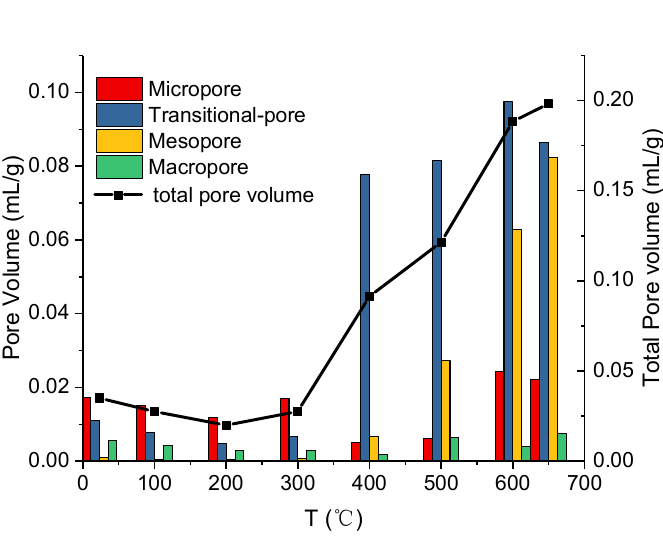
Figure 8. Diagram of the relationship between pore volume and temperature by MIP.